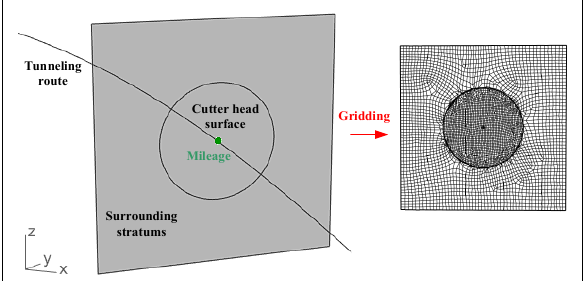
Figure 4 . Illustration of the cross-section modelling and grid division